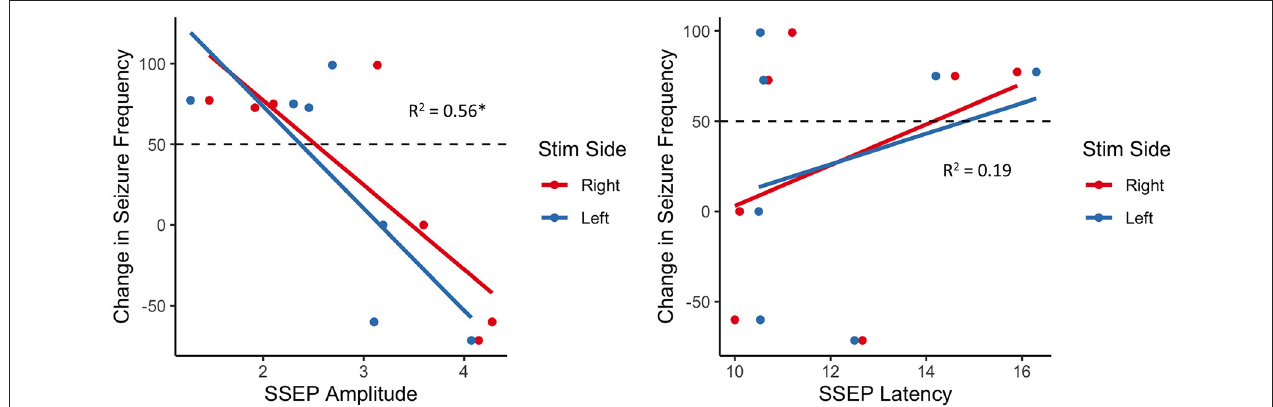
FIGURE 1 | Association between change in seizure frequency and brainstem SSEP amplitude (left) and latency (right); there is a robust negative relationship between SSEP amplitude and change in seizure frequency, with responders (above dashed line) generally exhibiting lower amplitudes than non-responders (below dashed line); * p <